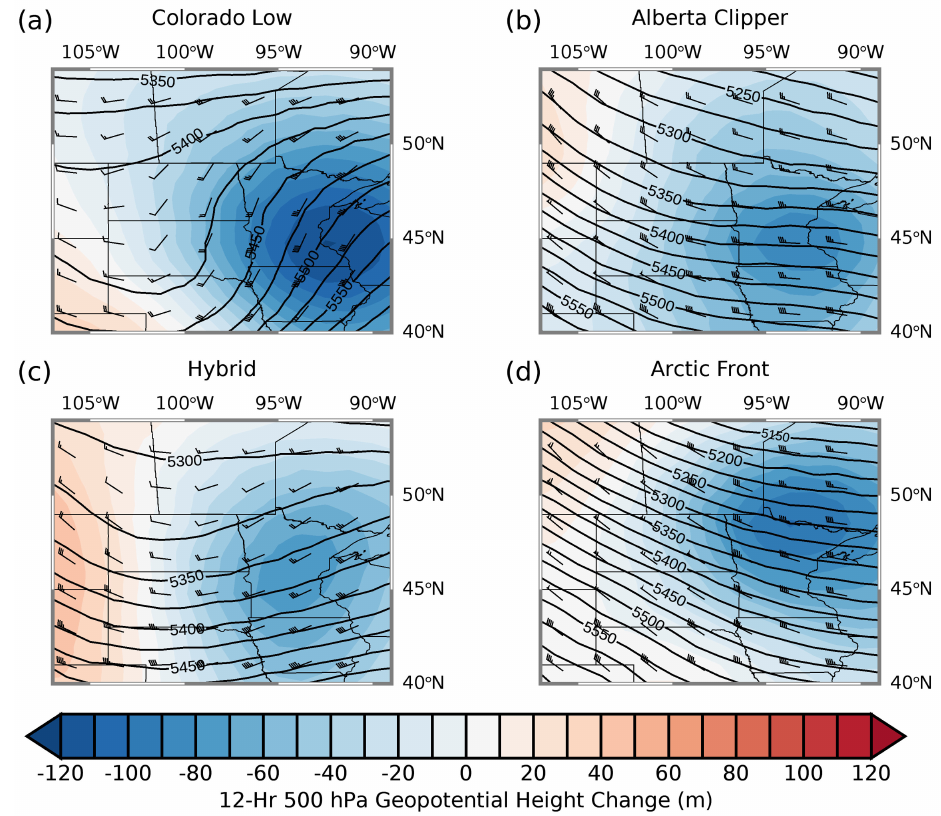
Figure 5. NARR composite plots of 500 hPa Geopotential heights (m) and wind barbs (kts) 12 hr prior to the midpoint of ( a ) Colorado Low, ( b ) Alberta Clipper, ( c ) Hybrid, and ( d ) Arctic Front blizzards. 12-h 500 hPa height change (midpoint—12 hr prior) is provided by shaded